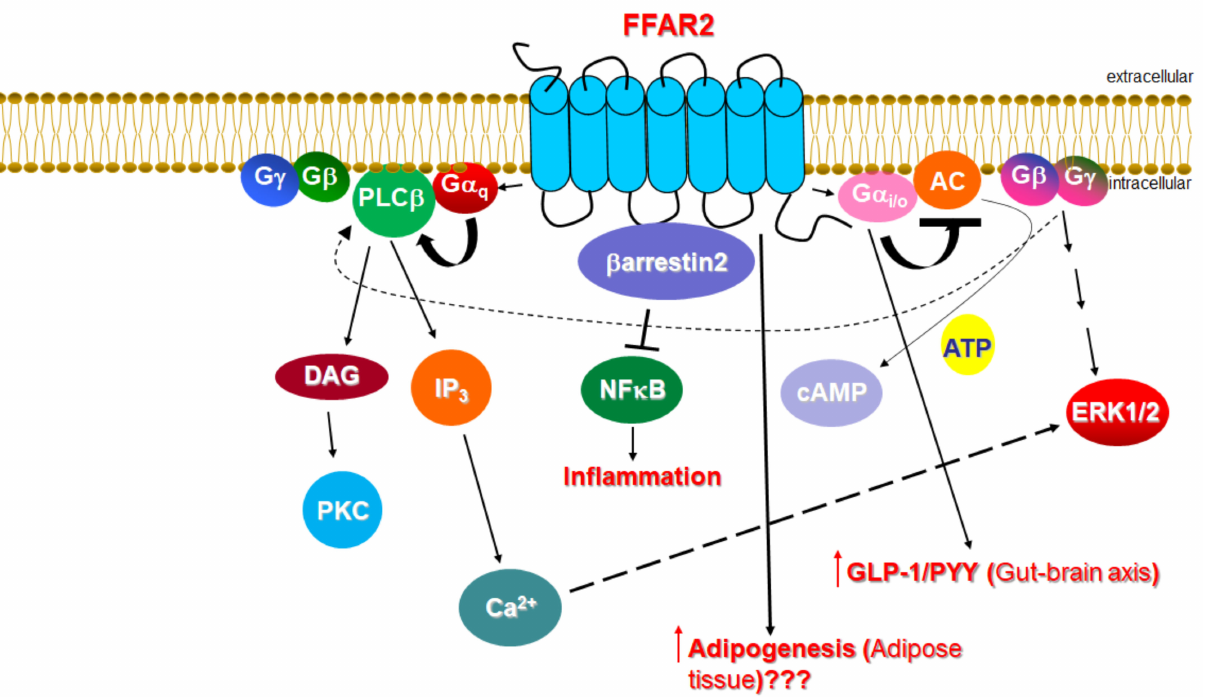
Figure 1. The cardiovascular physiology relevant to FFAR2 signaling. AC: Adenylyl cyclase; DAG: Diacylglycerol; ERK: Extracellular signal-regulated (mitogen-activated protein, MAP) kinase; IP 3 : Inositol 1 (cid:48) , 4 (cid:48) , 5 (cid:48) -trisphosphate; PLC: Phospholipase C; PKC: Protein kinase C; “???” indicates a lack of consensus (currently) for the action depicted. (See text for details and for all other molecular acronym